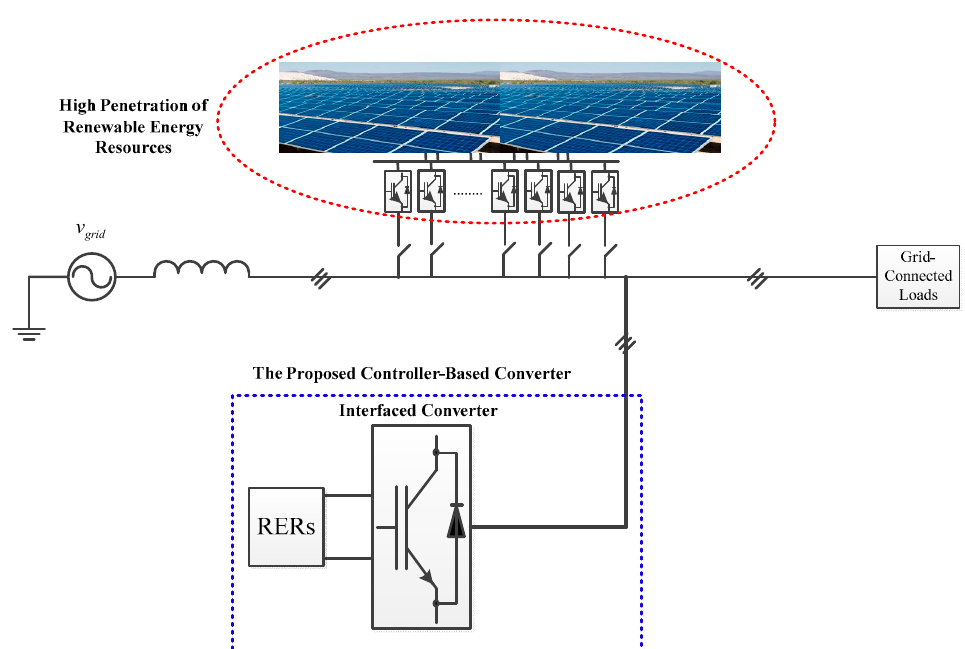
Figure 1. General structure of the high penetration renewable energy sources. RERs: Renewable Energy Sources.